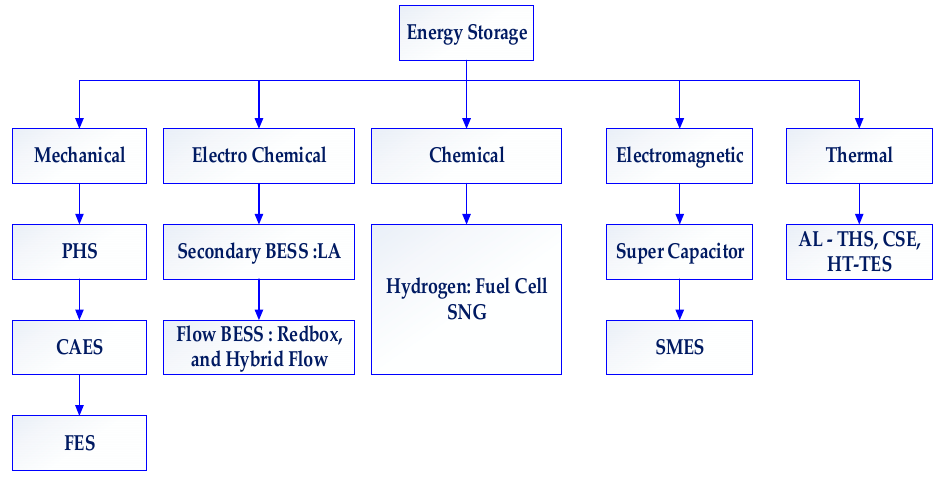
Figure 1. The hierarchical flow of energy storage systems.